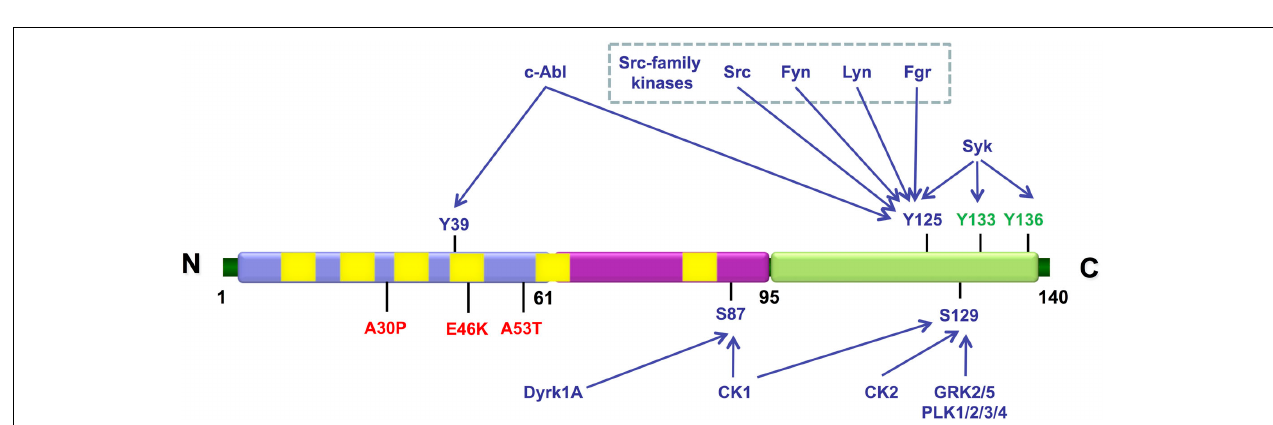
FIGURE 2 | Schematic representation illustrating the various residues in aSyn that can be phosphorylated in vivo (represented in blue) and in vitro (represented in green). The mutations associated with familial PD are shown in red. The N-terminal amphipathic region of the protein is represented in blue, the hydrophobic central region that